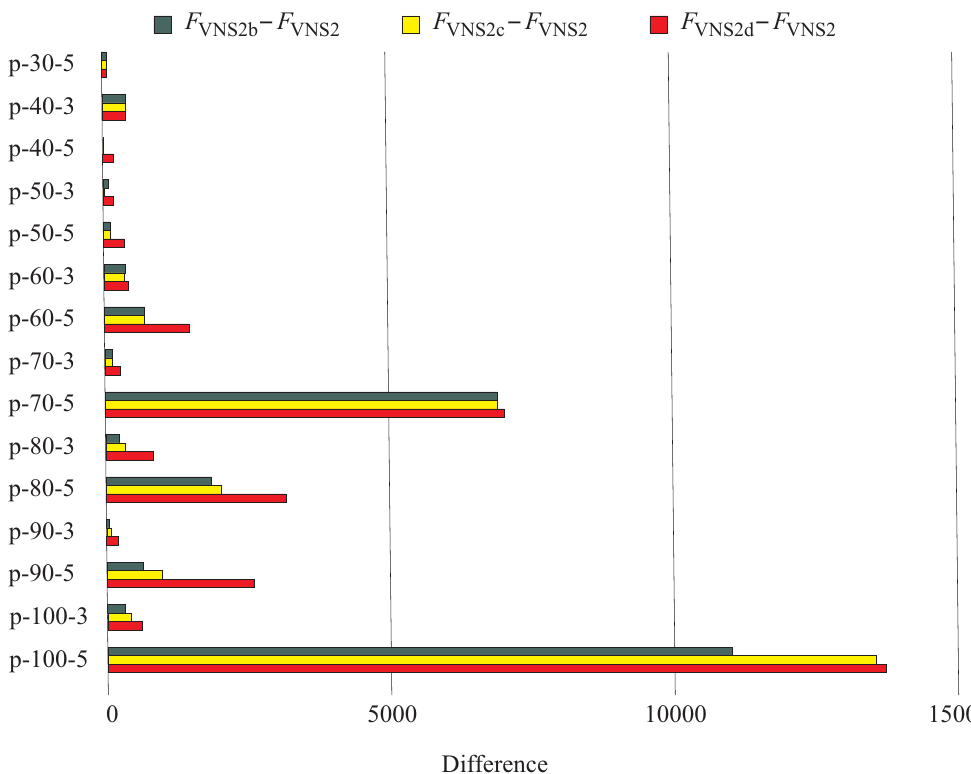
Figure 12. Difference in solution values between the VNS2 algorithm and VNS2 variations VNS2b, VNS2c, and VNS2d: the case of the F ∗ values.